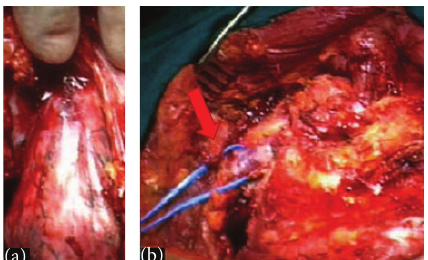
Figure 1: Intraoperative view of a superior sulcus tumor: (a) The nervous and vascular structures lie above the tumor mass. With a correct surgical approach a posterior chest wall attached to round- shaped lesion was isolated from surrounding soft tissues. (b) The lesion was entirely removed without injury of the nervous and vascular structures. A full red arrow shows the integrity of the subclavian